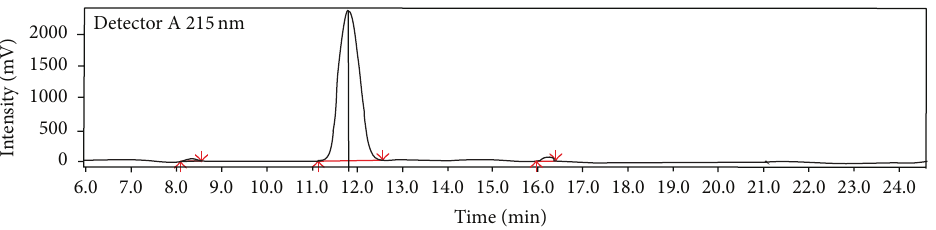
Figure 1: Typical chromatogram of the obtained Ribavirin.